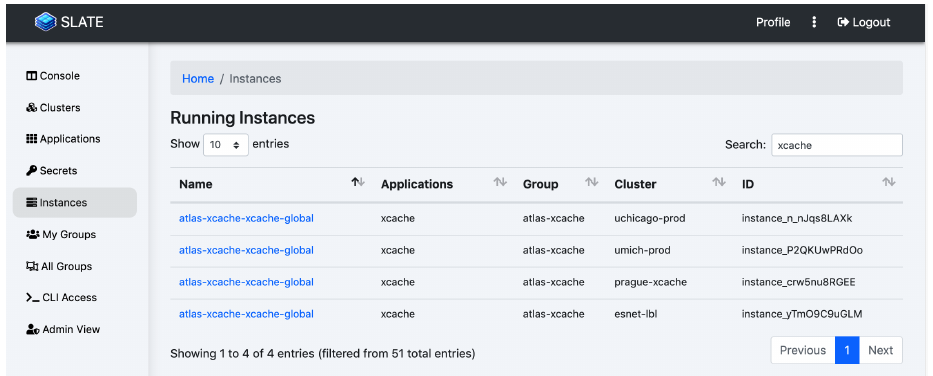
Figure 7: The SLATE console display of running XCache instances across the cluster net- work, with navigation links to detailed state and logging information for each of the deployed service